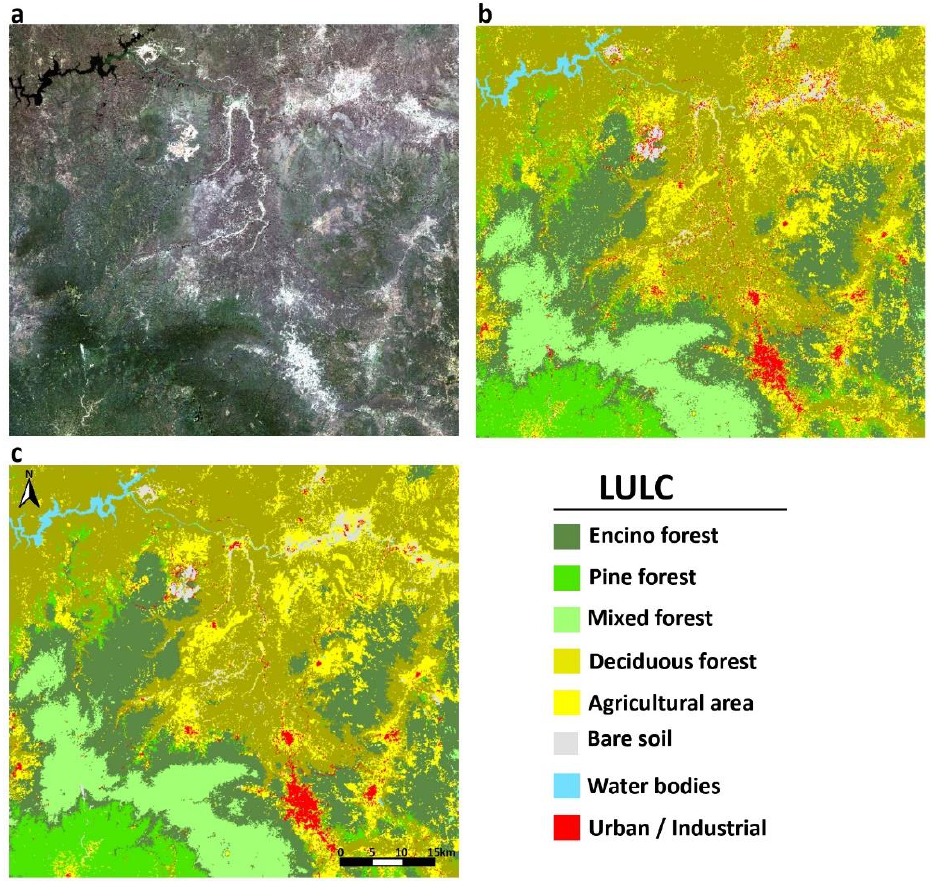
Figure 7. Base date. ( a ) True-color composition image (RGB bands), ( b ) Classified image, and ( c ) Classified image with the reduced salt-and-pepper noise.